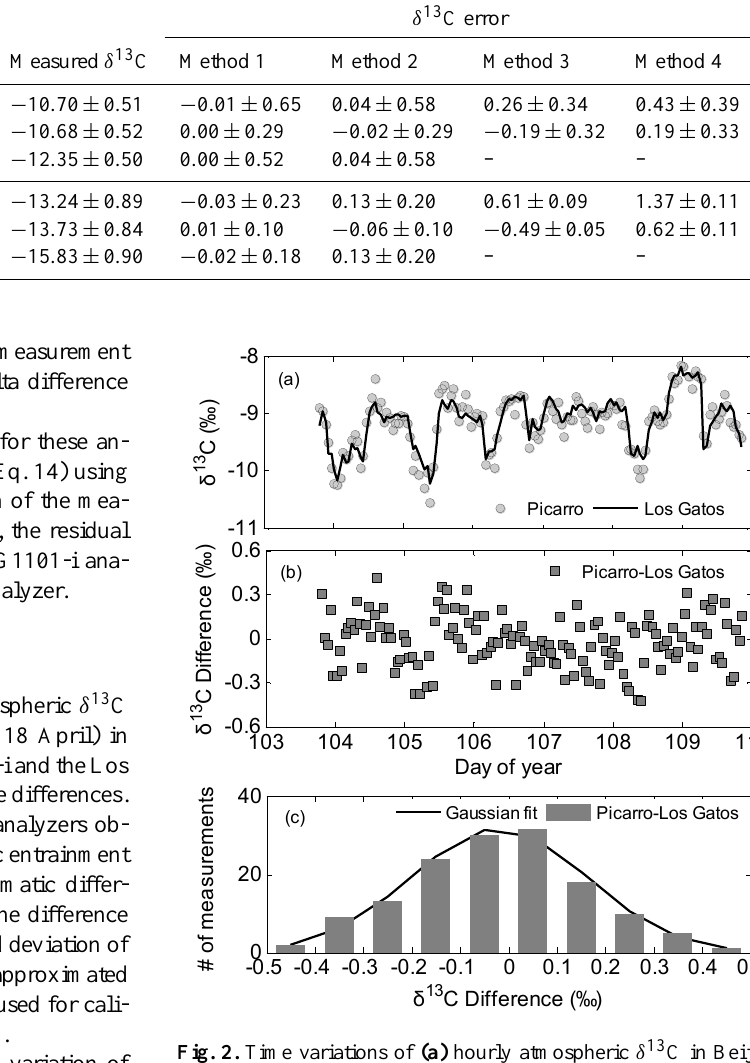
Table 1. Intercomparison of four δ 13 C calibration methods. In the case of Method 1–2, one of the three standard gases (Std1, Std2, and Std3) was treated as the target of measurement and the other two were used for calibration. In the case of Method 3, Std3 was used in conjunction of either Std1 or Std2 as the calibration pair. In the case of Method 4, Std3 was used to calibrate the measurement of St1 and Std2. Standard deviations are for hourly measurements ( n = 24). CO 2 mixing ratios are in ppm and delta measurements are in ‰. δ 13 C error